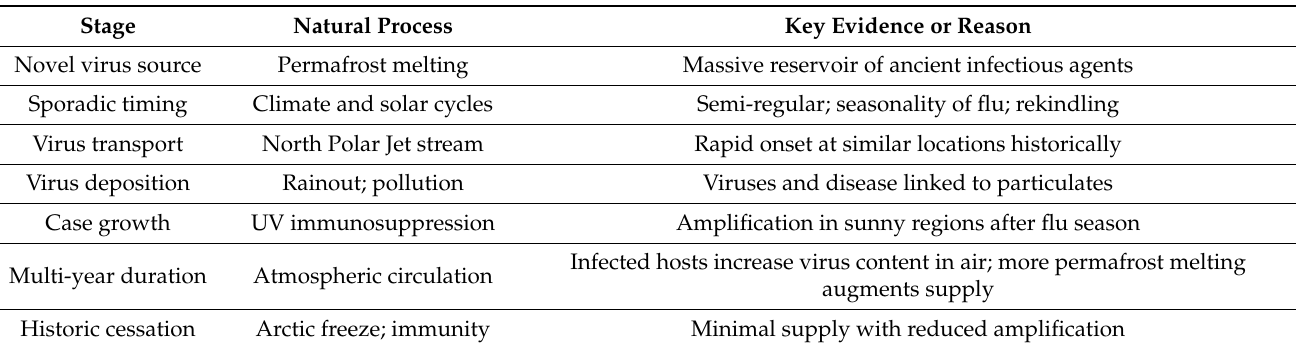
Table 1. Synopsis of our model linking stages in the development of major respiratory virus pandemics to natural phenomena and environmental